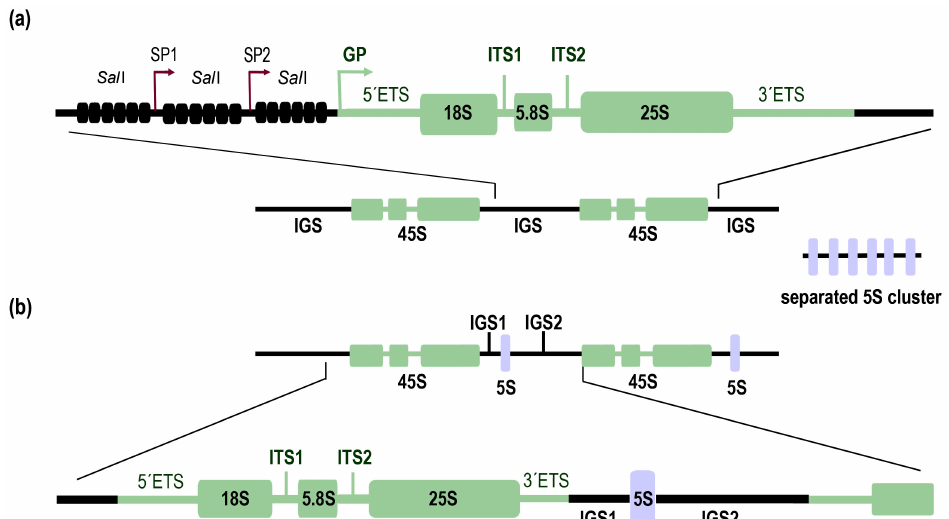
Figure 1. Organization of nuclear ribosomal RNA (rRNA) genes in plants. ( a ) A schematic view of rDNA organization in Arabidopsis thaliana S-type. A single 45S gene unit consists of three genes (18S, 5.8S, and 25S) transcribed together as a single transcript. Genes are separated by internal transcribed spacers (ITS1 and ITS2). Borders of 45S rDNA are formed by external transcribed spacers (5’ETS and 3’ETS). Adjacent 45S rDNA units are separated from each other by intergenic spacers (IGS). 5S rDNA is located at a separate locus. ( b ) A schematic view of rDNA organization in Physcomitrella patens L-type. 45S rDNA is organized similarly to A. thaliana with a different 5S rDNA position. The 5S rRNA gene is linked to 45S rDNA and is incorporated into the